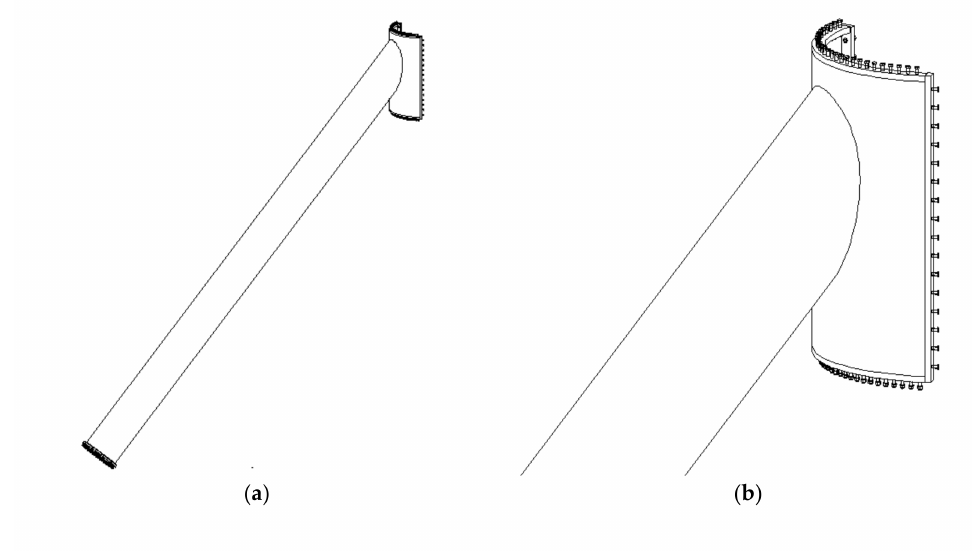
Figure 3. Segmental upper junction piece: ( a ) upper section of upper inclined leg with welded segmental upper junction piece and ( b ) details of a segmental upper junction